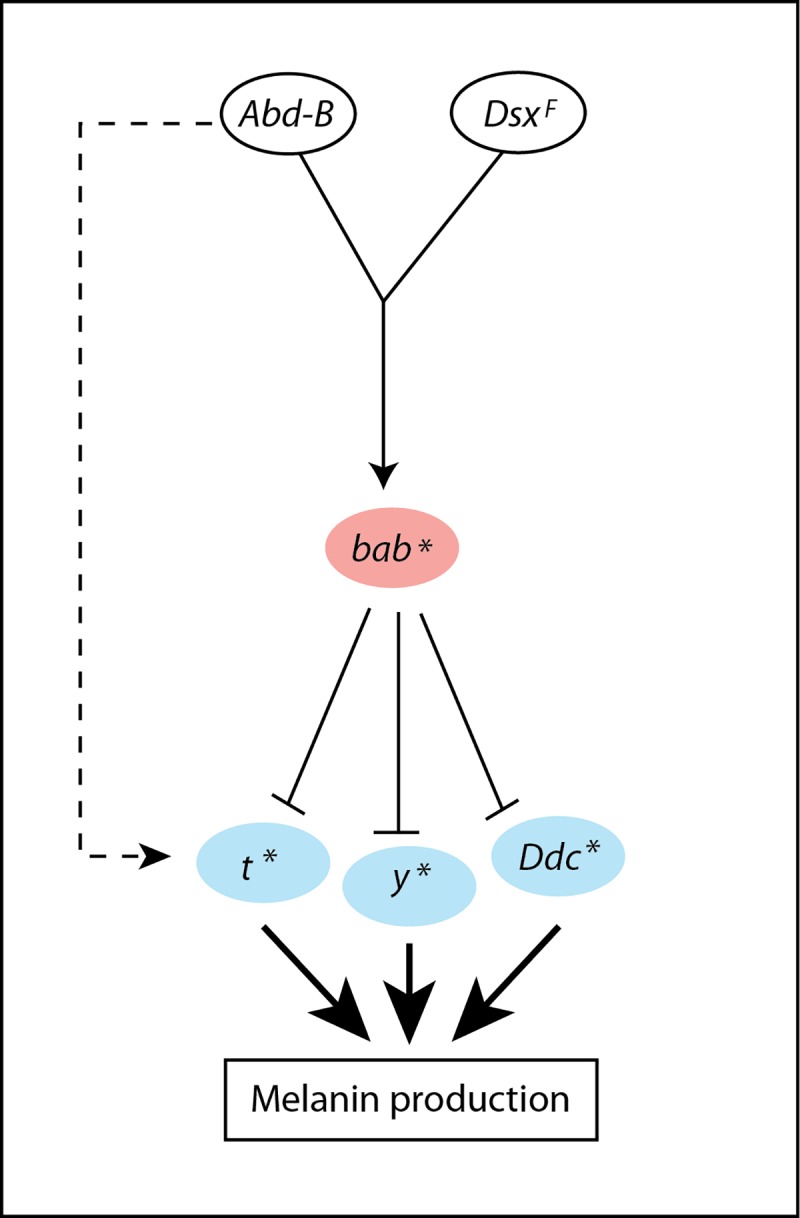
Gene regulatory network mediating the effect of temperature on female abdominal pigmentation in the posterior abdomen.In the posterior abdominal epidermis of females, bab is activated by Abd-B and DsxF. bab expression is higher at high temperature (pink), which leads to a lower expression of t, Ddc and y at high temperature (blue). The resulting effect is a decrease of melanin production at high temperature. Abd-B might activate t at low temperature, which would explain the high expression of t when bab expression is low. Asterisks indicate the genes for which expression in the posterior abdominal epidermis was demonstrated to be sensitive to temperature.